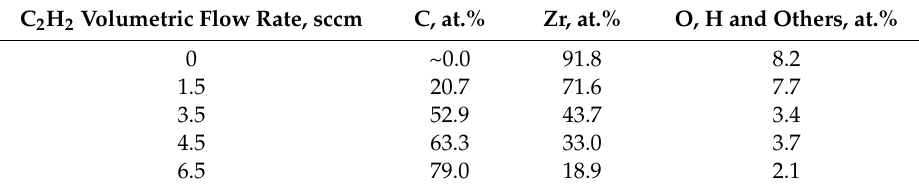
Table 2. Chemical composition of the Zr–C